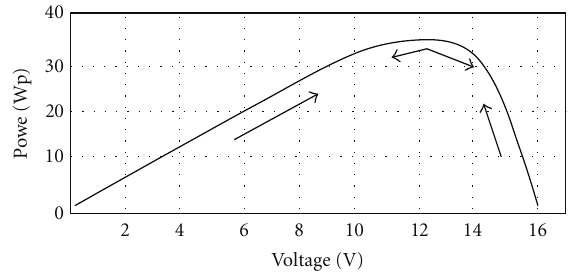
Figure 19: Power graph for P and O